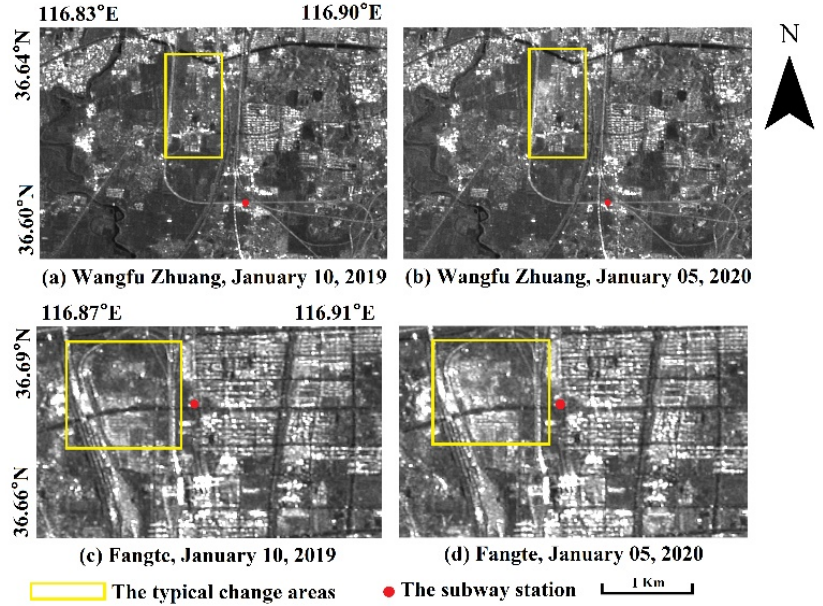
Figure 2. Sentinel-1 A intensity images around ( a , b ) Wangfu Zhuang Station and ( c , d ) Fangte Sta- tion.